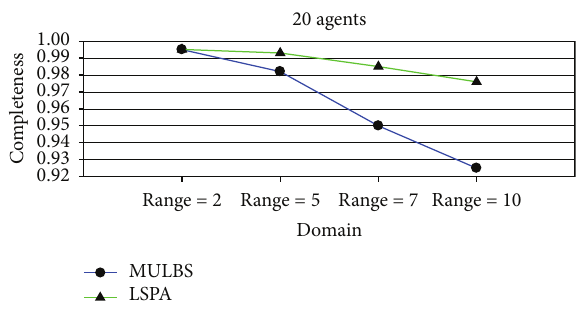
Figure 11: Completeness with density 3 and domains 2, 5, 7, and